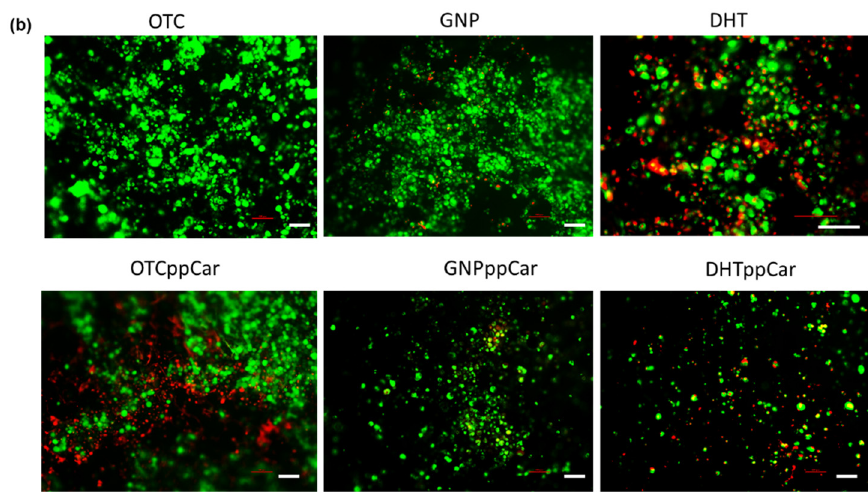
Figure 9. The cellular compatibility of fabricated OTC-I bioscaffolds with ( a ) human dermal fibroblasts (HDFs) and ( b ) human epithelial keratinocytes (HEKs) after 24 h incubation post-seeding at 37 °C. Scale bar is 100 μ m.